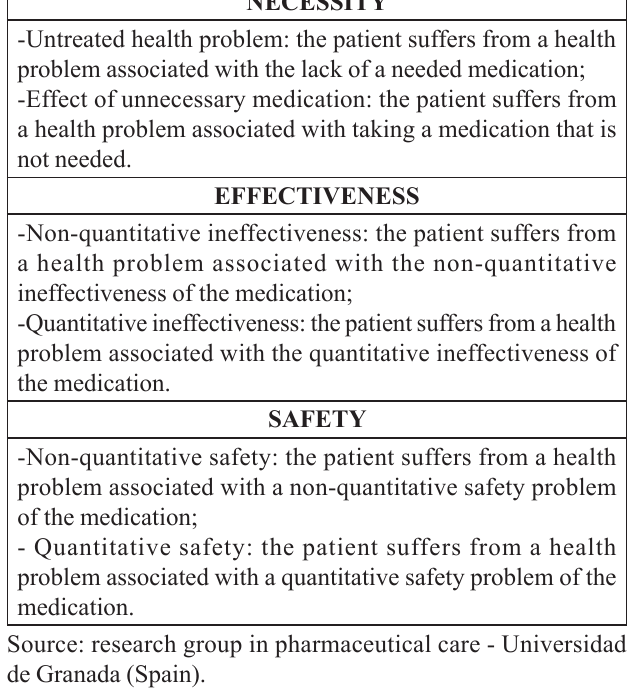
FIGURE 1 - Classification of Negative Outcomes associated with Medication (NOM) according to the Third Consensus of Granada,